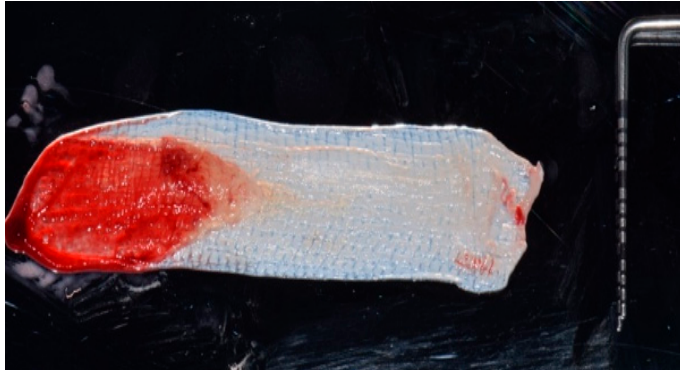
Figure 4. PRF membrane obtained from the patient’s blood sample.